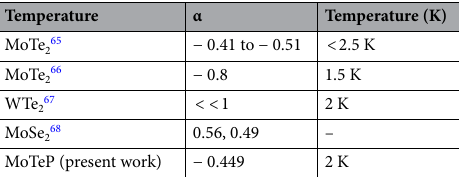
Table 1. The values of α extracted from HLN